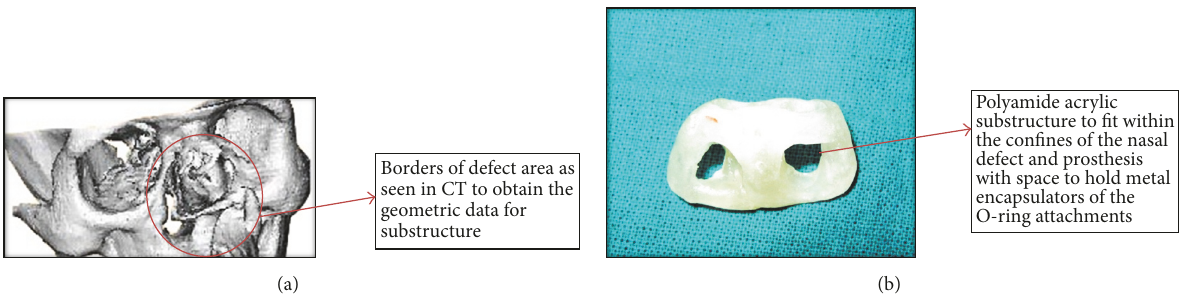
Figure 3: (a) CT image of defect area. (b) Polyamide acrylic